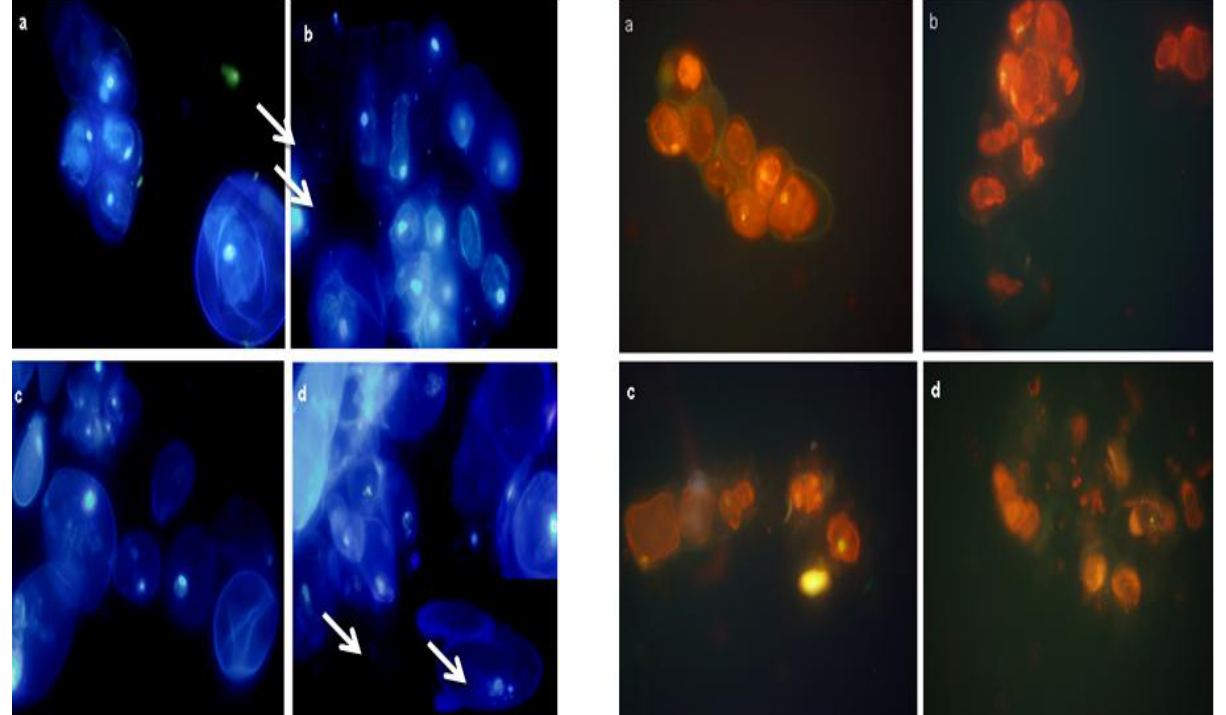
Fig. 2. Morphology of the cells cytoplasm stained with acridine orange a) controls, a distinct cytoplasm was observed and appeared round (arrows) b) the cells treated with 10 mM of Cd(NO 3 ) 2 c) the cells treated with 30 mM of Cd(NO 3 ) 2 d) the cells treated with 50 mM of Cd(NO 3 ) 2 (20X magnification)